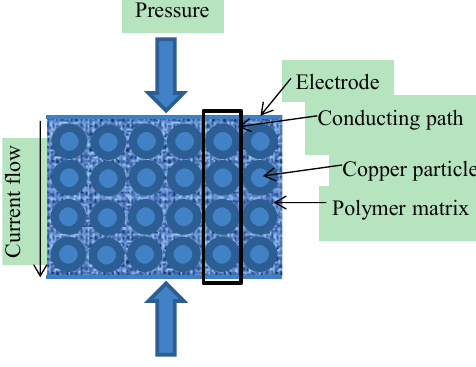
Figure 4. Schematic diagram of the piezo-resistive